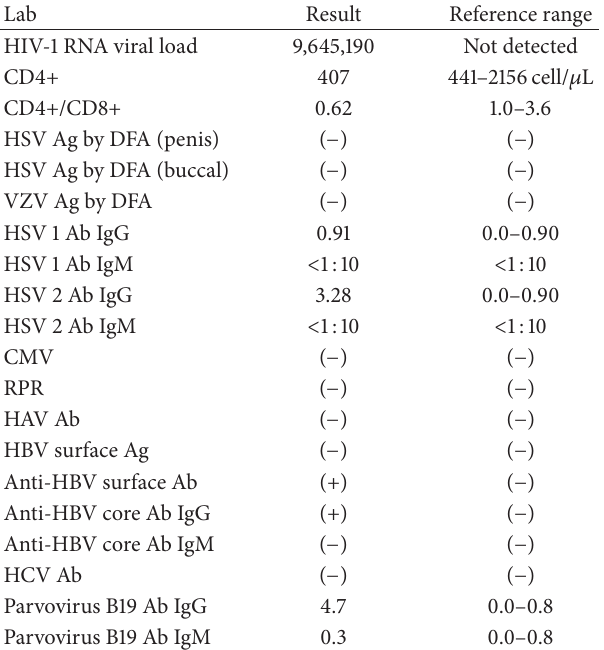
Table 1: Results of the patient’s infectious work-up demonstrating a significantly elevated viral load and slightly depressed CD4 cell count. The remainder of the evaluation was negative, showing no signs of other active infectious processes. Ab, antibody; Ag, anti- gen; DFA, direct florescent antibody test; CMV, cytomegalovirus; HAV, hepatitis A virus; HBV, hepatitis B virus; HCV, hepatitis C virus; HSV, herpes simplex virus; IgG, immunoglobulin G; IgM, immunoglobulinM;RPR,rapidplasmareagin;VZV,varicellazoster